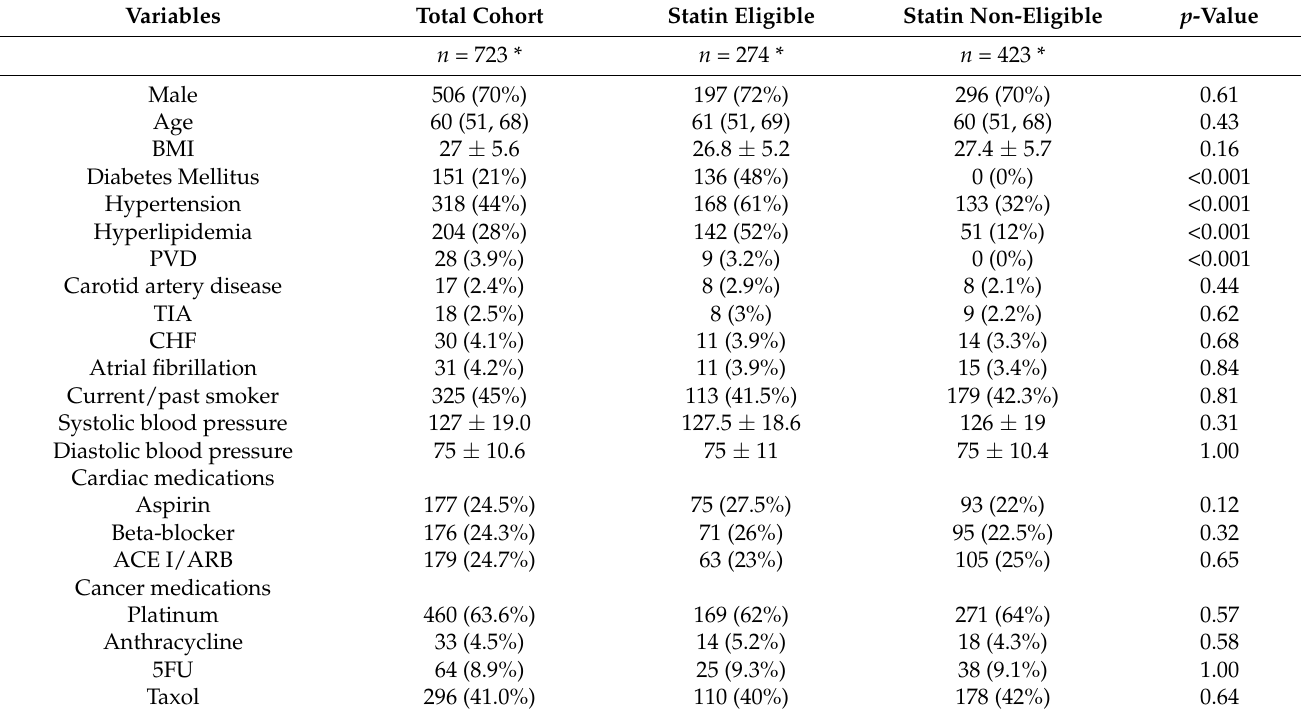
Table 2. Demographics—Comparison of statin eligible vs. statin non-eligible groups based on USPSTF